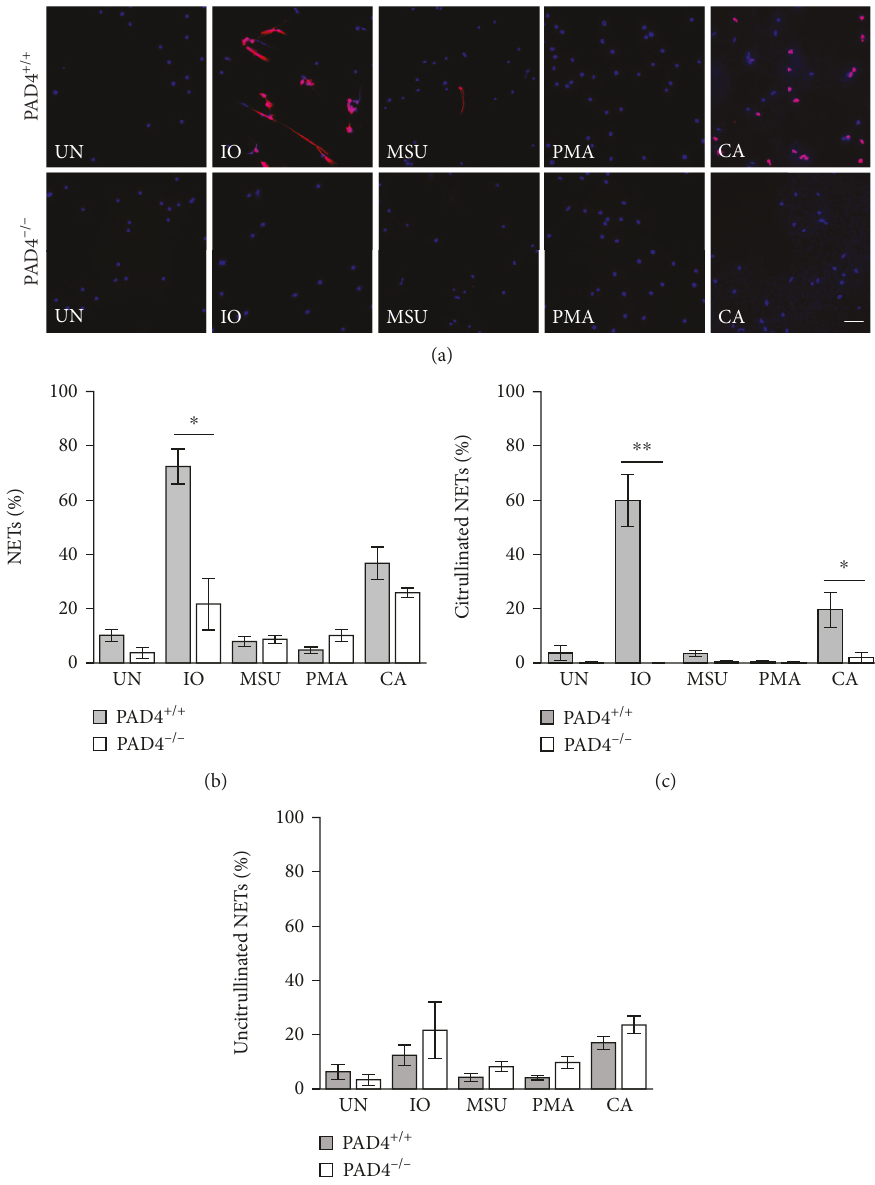
Figure 3: PAD4 is required for the formation of citrullinated NETs in murine neutrophils. Bone marrow neutrophils from PAD4 +/+ and PAD4 -/- mice were left untreated (UN) or were treated with ionomycin (IO), MSU, PMA, and C. albicans (CA), fi xed, and stained with DAPI (blue) and anti-citrulline antibody (pink). (a) Representative images at 400x, scalebar = 50 μ M . The number of neutrophils and NETs were quanti fi ed. Graphs depict the average and SEM for percent of neutrophils that formed total NETs (b), citrullinated NETs (c), and uncitrullinated NETs (d) for each condition with percent NETs for each stimulant compared between PAD4 +/+ and PAD4 -/- mice. For all panels: n = 4 ; ∗ p < 0 05 and ∗∗ p < 0 01